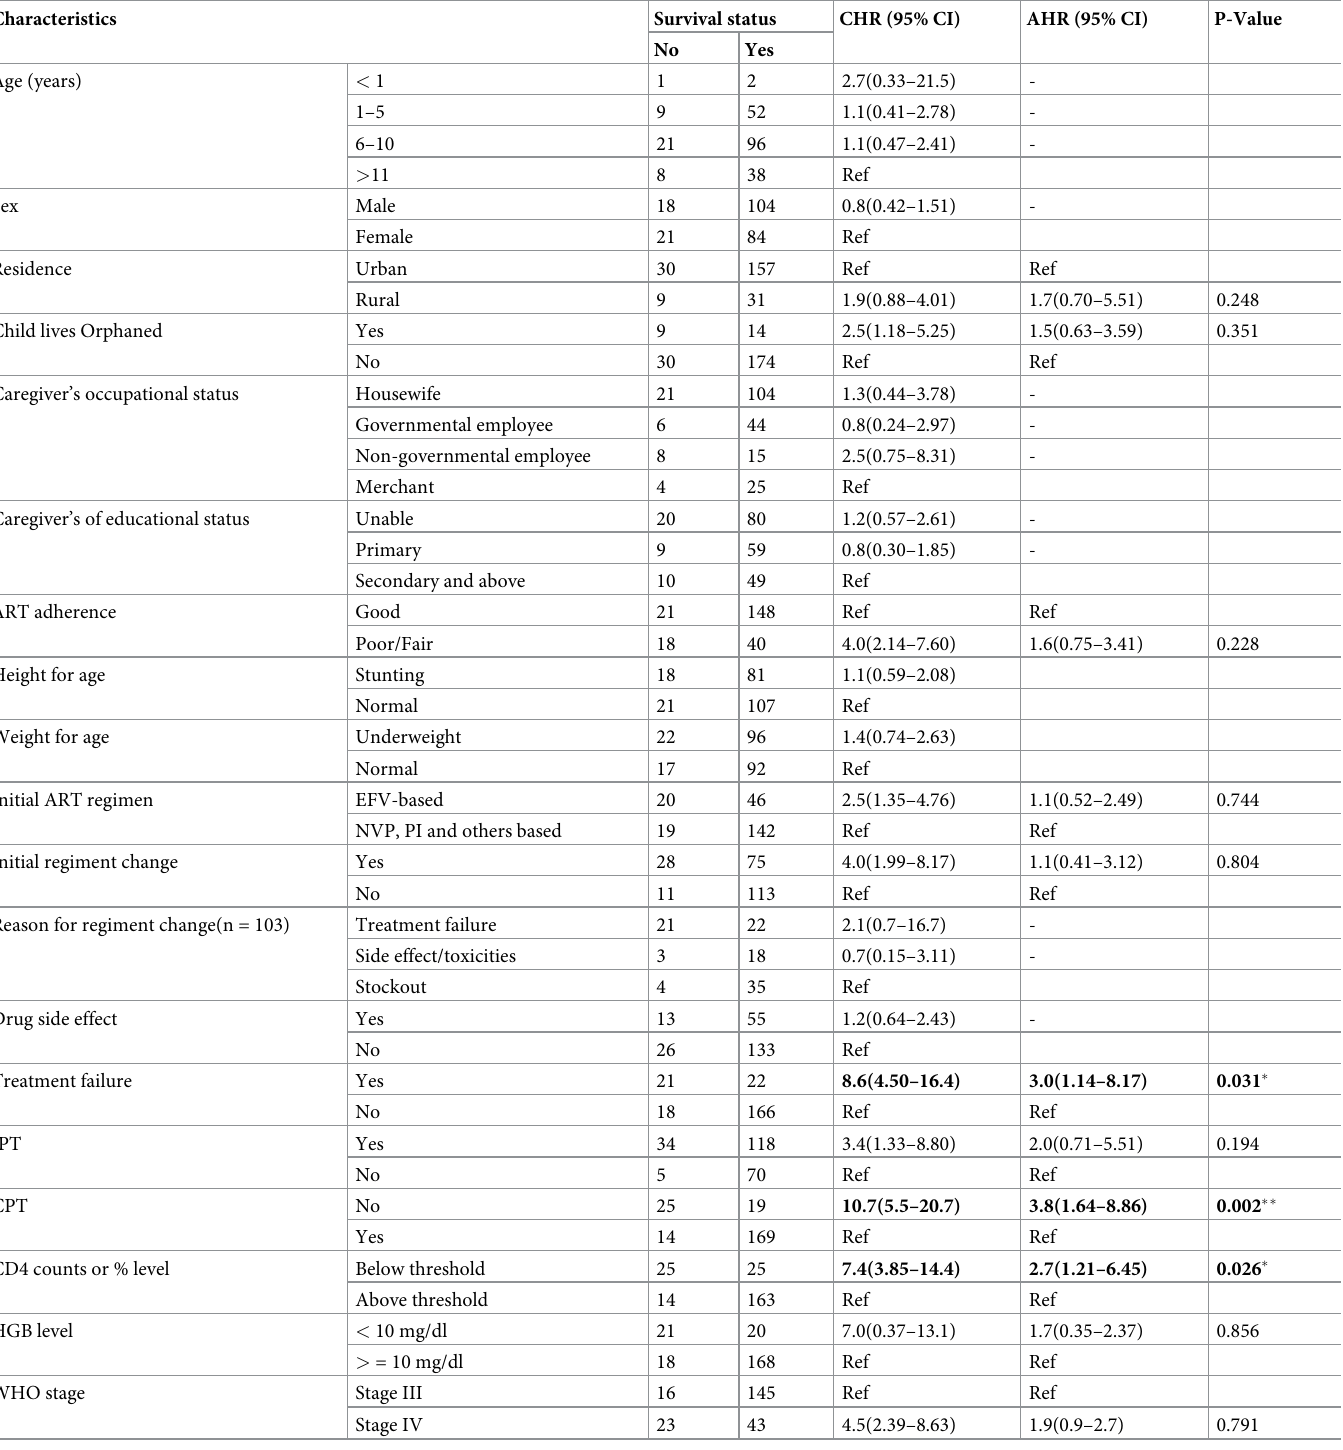
Table 3. Bivariable and multivariable Cox-regression of predictor variable among TB and HIV co-infected children after test and treat strategies in northwest Ethi- opia hospitals, 2021.